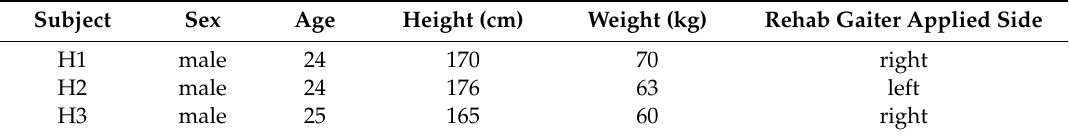
Table 5. Information of the health subjects.